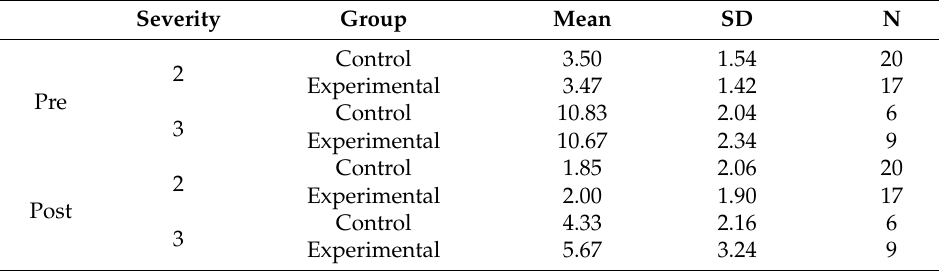
Table 3. Number of non-produced sounds for the experimental and control groups in the pretest and post-test assessment.